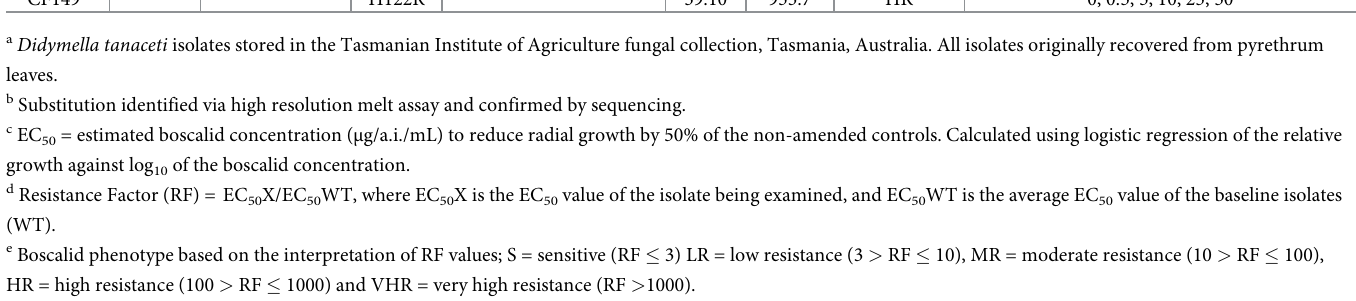
sensitivity in the SdhB, SdhC or SdhD (Table 2). No isolates containing compound substitu- tions of interest were identified. Following application of the spring fungicide program the percent of isolates sampled in November 2012 containing a Sdh substitution increased to 98.9% (Table 2). This result coincided with no detection of WT isolates in three of the four fields (Table 2). The SdhB-H277Y substitution was the most common Sdh substitution in each field, irrespective of sampling period. Multinomial logistic regression of genotype frequency indicated a significant interaction between field and time of sampling ( P = 0.0065). Post-hoc pairwise comparisons between sampling periods within fields and substitution found that sig- nificant reductions in WT frequency occurred from August to November in fields 12–63242 and 12–70046 (Table 2). Significant increases ( P < 0.05) in Sdh substitution frequency within fields were observed for SdhB-H277R (Field 12–51907) and SdhC-S73P (Field 12–70047) from August to November (Table 2). Conversely, significant decreases ( P < 0.05) over the same